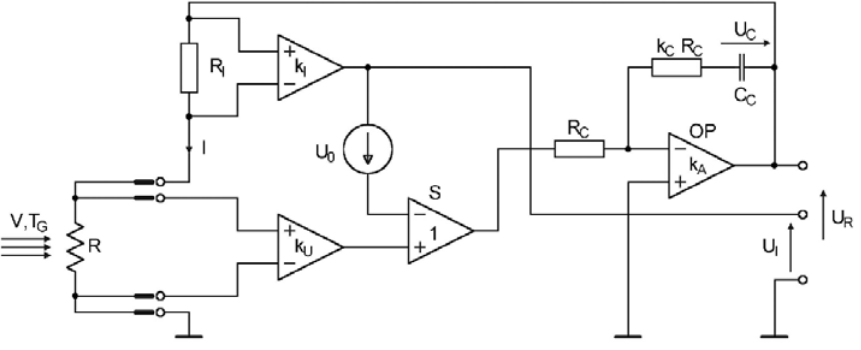
Figure 1. A simplified schematic diagram of the measuring